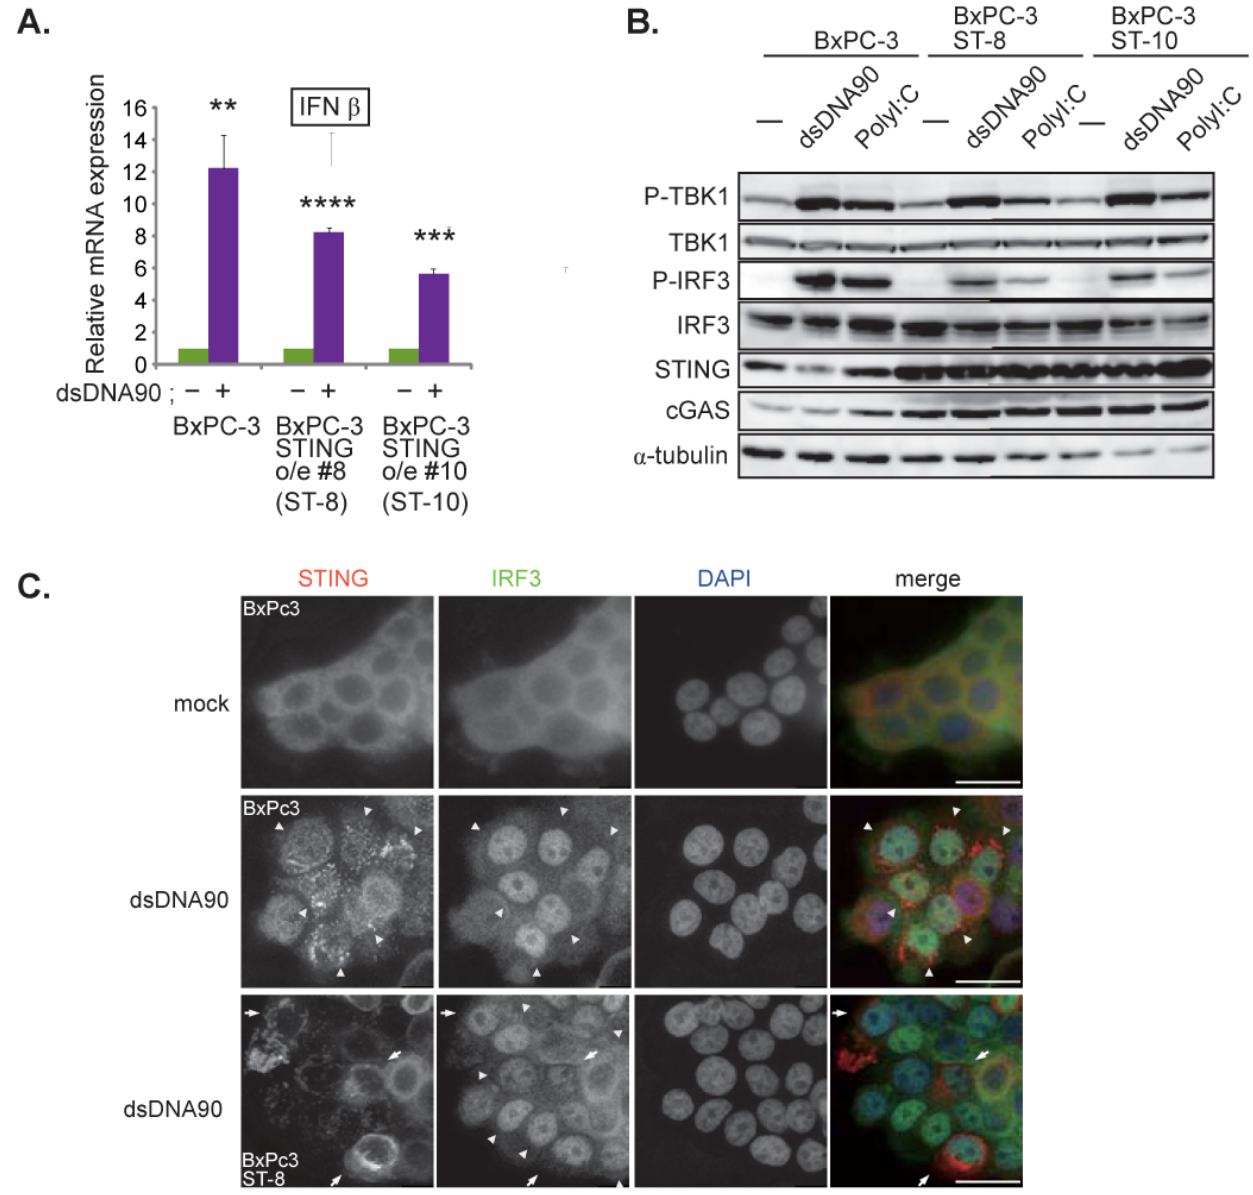
Figure 2. BxPC-3 cell line has a responsive STING pathway. ( A ) Induction of IFN β . At 6 h after transfection of dsDNA90 (3 µ g/mL) into BxPC-3, BxPC-3 ST-8 and BxPC-3 ST-10 cells, samples were analyzed by RT-qPCR. IFN β expression was normalized relative to the expression of the G3PDH protein. Data are presented as mean ± SEM of 3 independent experiments. ( B ) Western blot analysis on the indicated proteins on the STING pathway. Cells were lysed after 6 h after transfection with dsDNA90 (3 µ g/mL) or Poly (I:C) (3 µ g/mL). ( C ) Images of the indicated cells at 6 h after transfection with dsDNA90 (3 µ g/mL). Cells were stained with anti IRF3 antibodies and anti-STING antibodies. Arrowheads depict cells with stacked STING and with intranuclear translocation of IRF3. Arrows depict cells with over expression of STING. Scale bar represents 20 µ m. ** p < 0.01, *** p < 0.001, **** p <